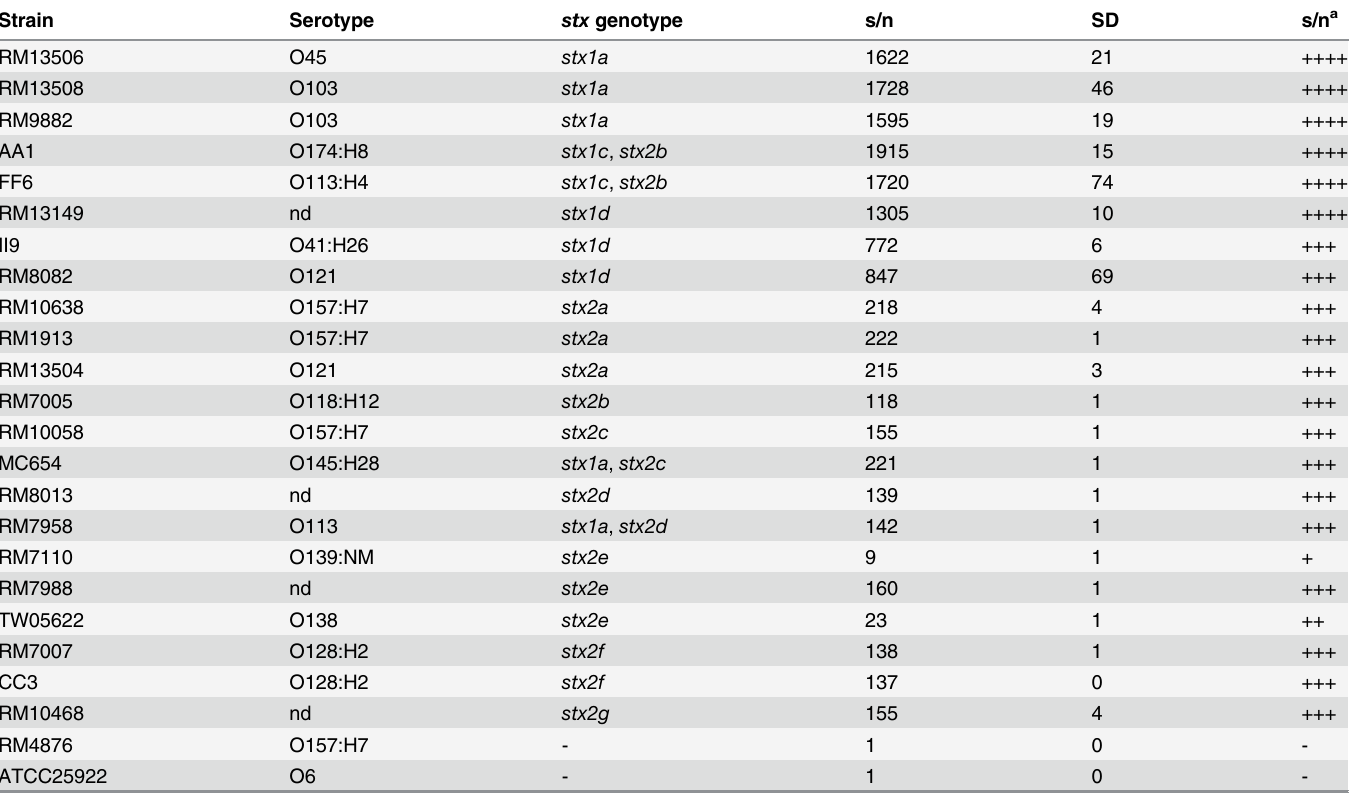
spleens were excised aseptically, and splenocytes were harvested. SP2/0 myeloma cell and splenocyte cell fusions were achieved using a polyethylene glycol-based protocol. Clonal hybridoma lines were then achieved with three rounds of cloning by limited dilution, regrowth, and screening. Table 2. Detection of Stx in culture supernatants of STEC strains by ELISA. Strain